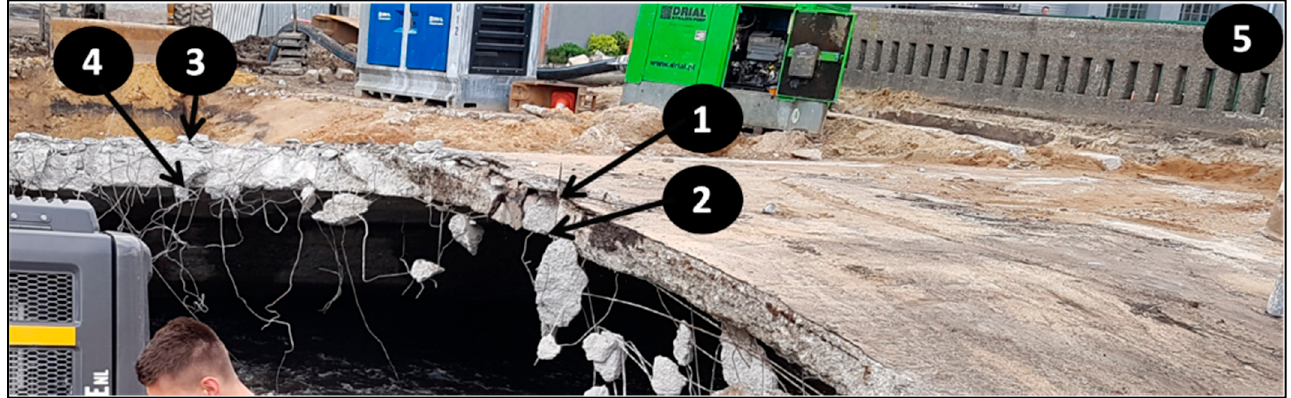
Figure 6. The RC (reinforced concrete) slab after removing the bituminous layer from the bridge. Liquid samples from the Kłodnica river W1 and W2 were taken in one visit at the location of the bridge (see Figure 9), in March 2020, to an amount of 2 L, and immediately tested. The W1 specimen was flowing water and the W2 specimen was water with bottom sediment. These samples were prepared for examination by isolating the water (by dynamic elution of the suspension) and sediment (dried at 40 ◦ C to a constant mass, after filtration of the suspension). The sediments include allochthonous material (sands, silts, and gravels that arise as a result of the destruction of the bottom and the banks of the river, but also mineral and organic suspensions discharged into surface water together with surface runoff and inflow waters, as well as industrial and municipal sewage) and indigenous material (inorganic and organic substances precipitating from water, plant, and animal organisms)